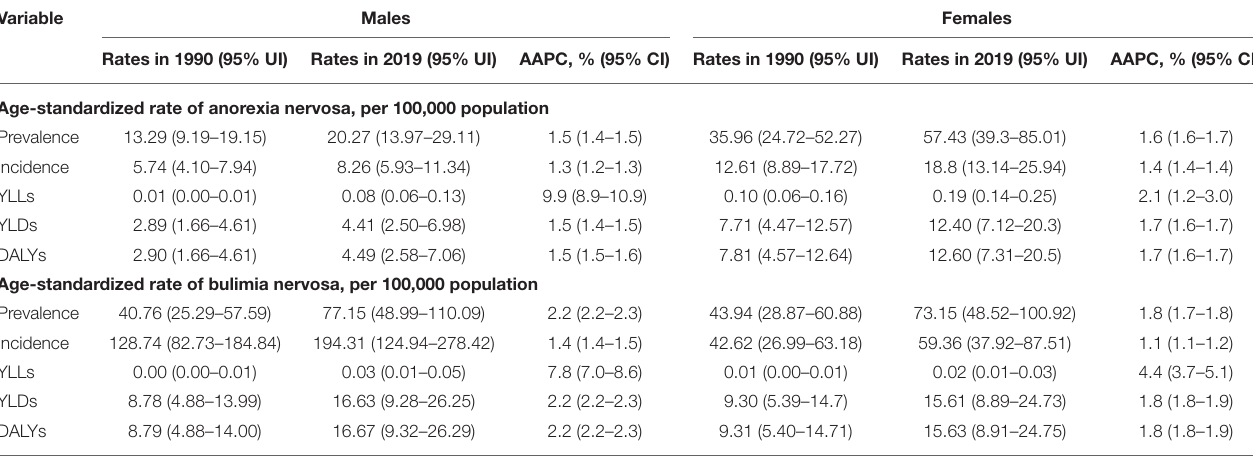
TABLE 1 | Trends in the burden of anorexia nervosa and bulimia nervosa between males and females from 1990 to 2019. Variable Males